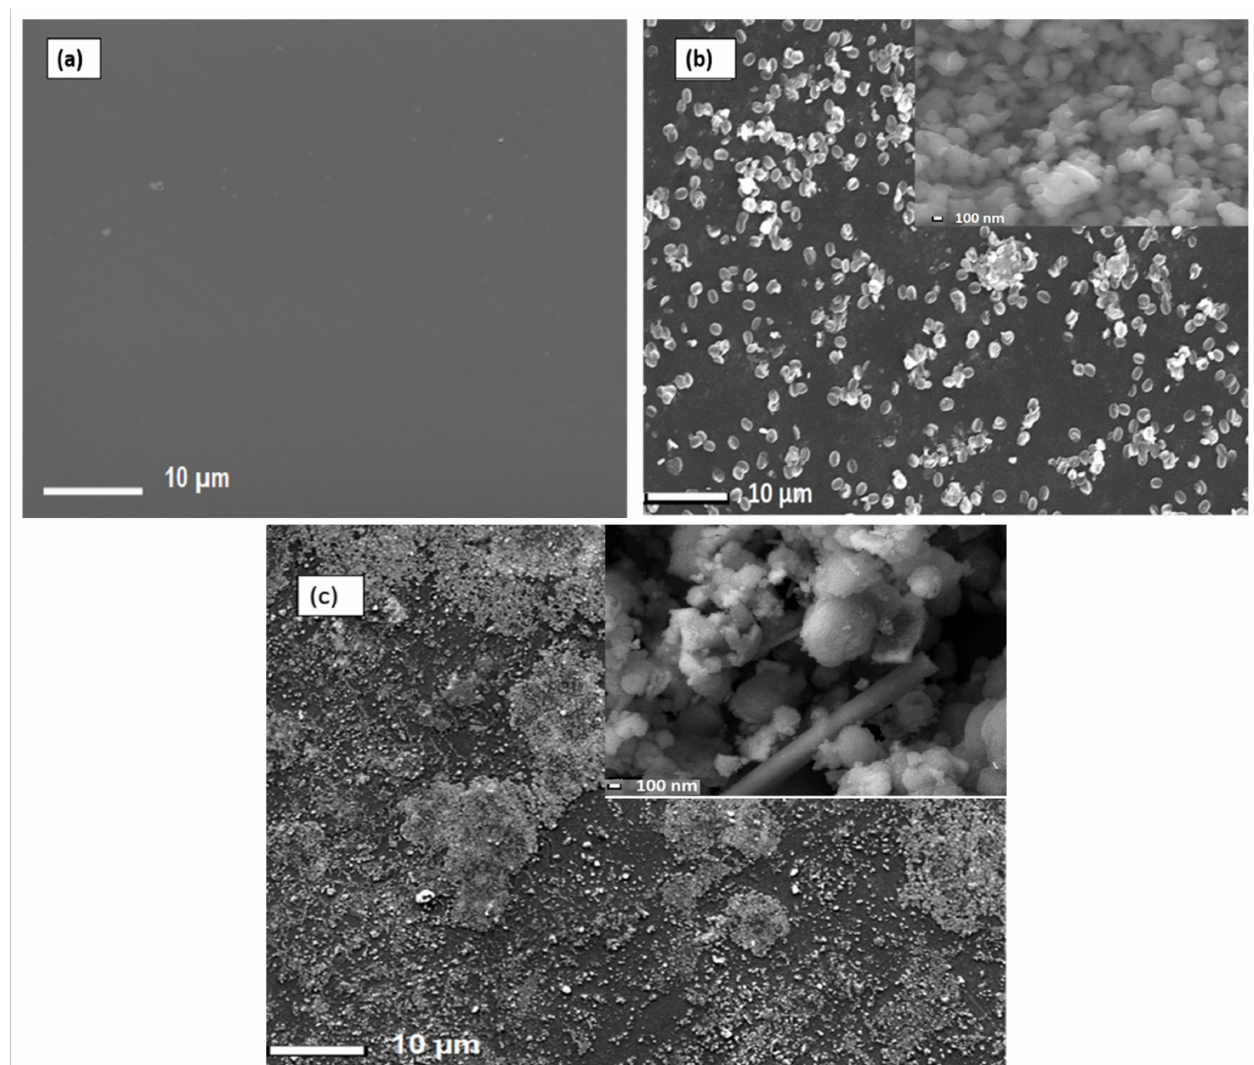
Figure 2. SEM micrograph of ( a ) Nafion ® 117 membrane and ( b ) Nafion ® ZrP (insert: ZrP nanoparti- cles) and ( c ) Nafion ® /S-ZrO 2 nanocomposite membranes (insert:S-ZrO 2 nanoparticles). Table 1. Surface roughness parameters of Nafion ® /S-ZrO 2 and Nafion ® /ZrP nanocomposite membranes.